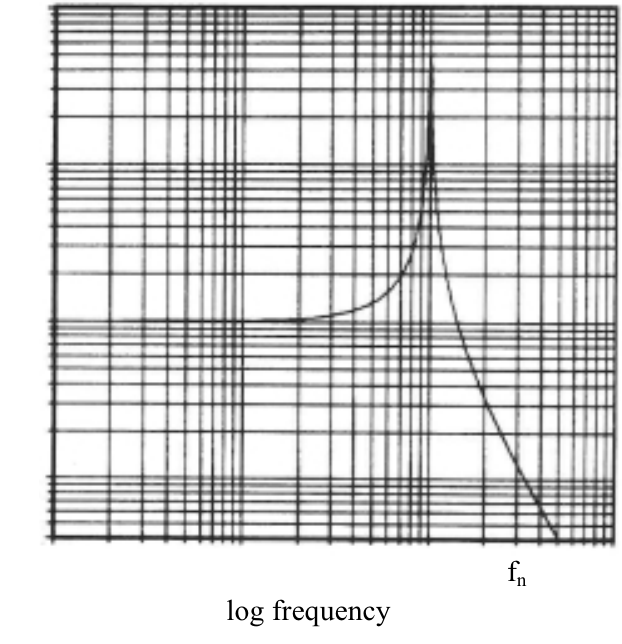
Fig. 6. Simple accelerometer dynamic model frequency response with single resonance f n .